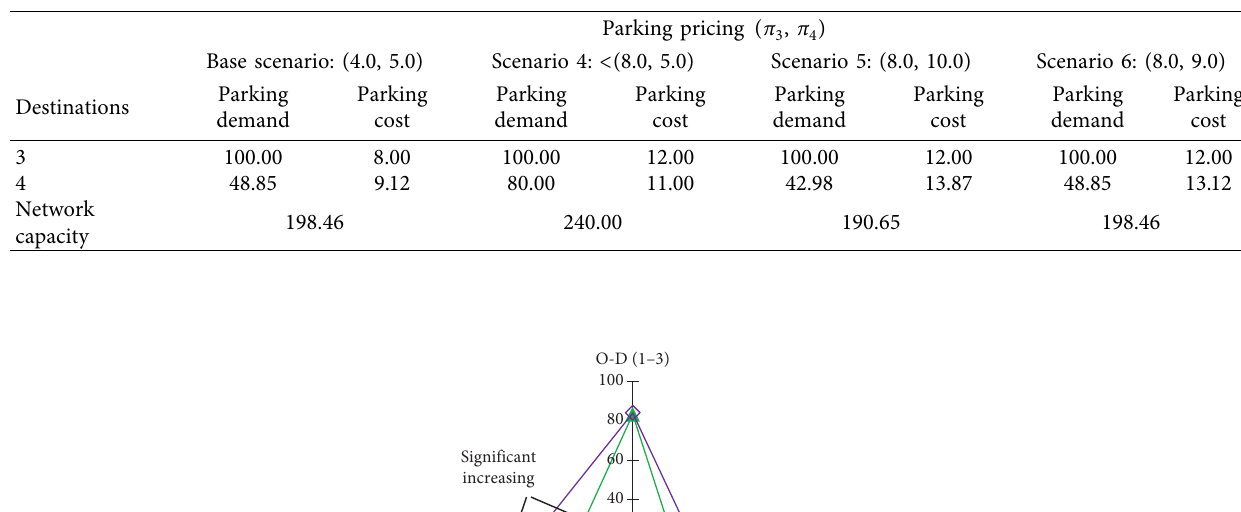
Table 8: Results of network capacity under different parking pricing